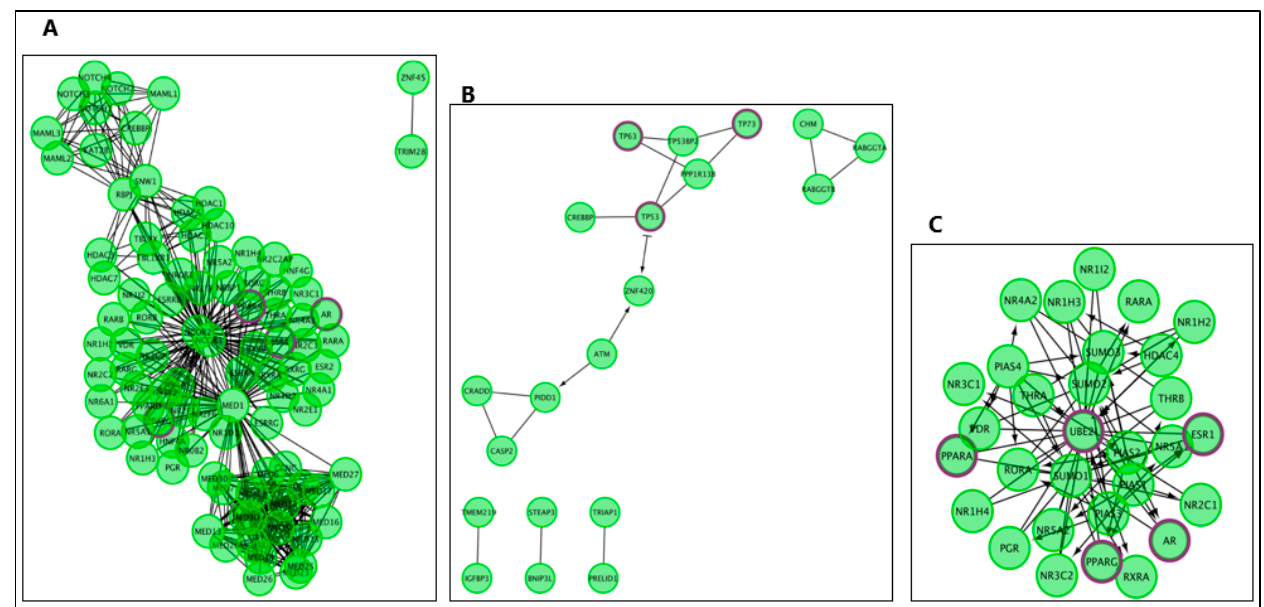
Figure 3. The Reactome pathways from Figure 2 converted into a functional interaction network. Sub-pathways within the original pathway diagrams were extracted into the FI network as well. Hit genes are displayed in a thick purple border in the FI network view for a hit pathway. ( A ) Generic transcription pathway. ( B ) TP53 regulates the transcription of death receptors and ligands. ( C ) SUMOylation of intracellular receptors. Table 6. Comparison of Longevity and AD Genes.